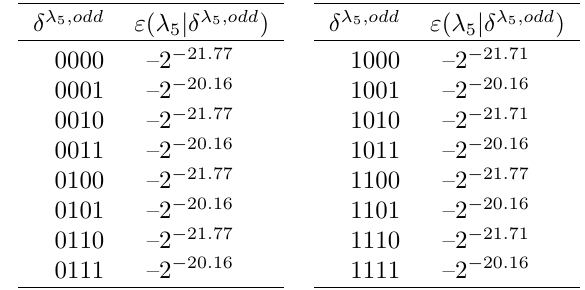
Table 10: Conditioning ε ( λ 5 ) on Each of the 16 Possible Values of δ λ 5